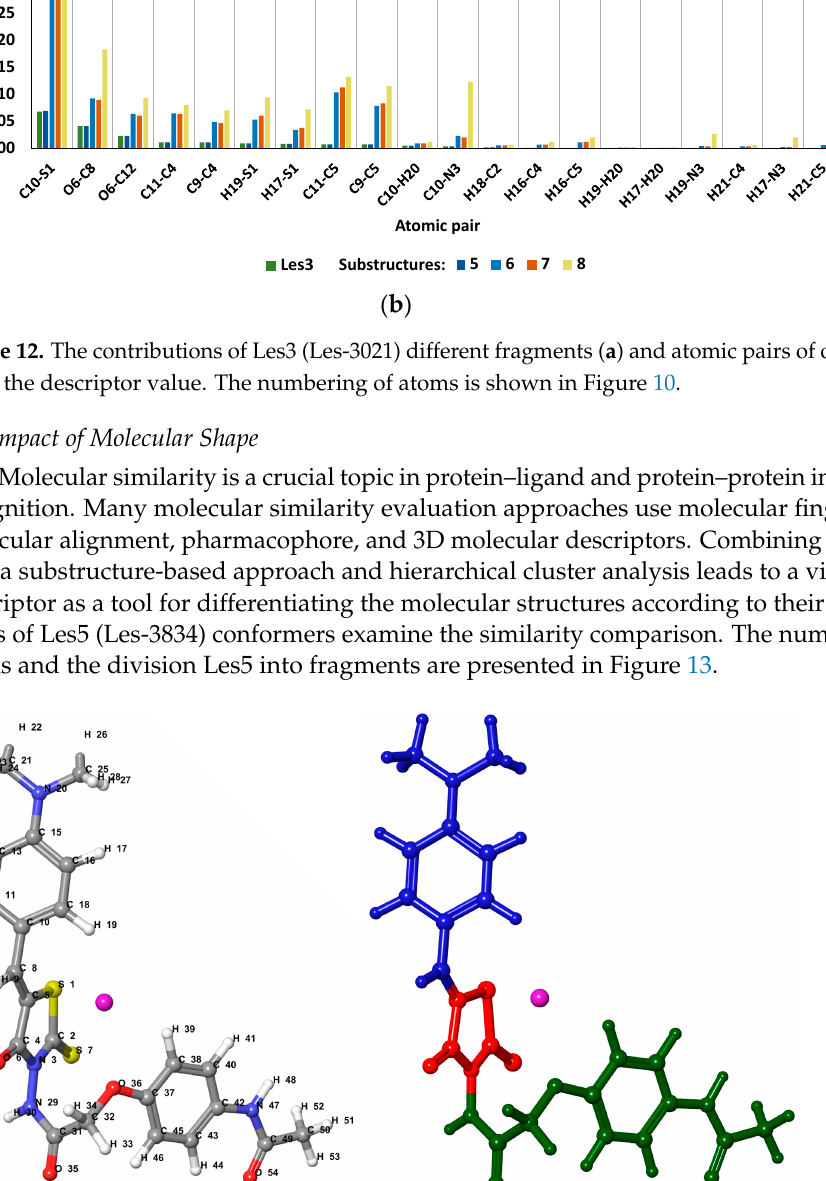
Figure 14. The contributions of 20 conformers of Les5 (Les ‐ 3834) to the HATS5m value. They are arranged in ascending order of the HATS5m value. Furthermore, to investigate the conformers’ shape variability, cluster analysis was performed using the unweighted pair group method with arithmetic mean (UPGMA) and the Euclidean distance as a measure of similarity (Figure 15). The Cophenetic Correlation Coefficient (CCC) equal to 0.7659 validates the consistency of the hierarchical clustering pattern (dendrogram). Finally, the CCC measures the degree of preservation of the paired distances resulting from the dendrogram concerning the actual distances. The tree indi ‐ cates the presence of three clusters in the data (Figure 15). The first cluster (yellow) corre ‐ sponds to linear compounds from the original data set. The groups blue and green consist 0.00